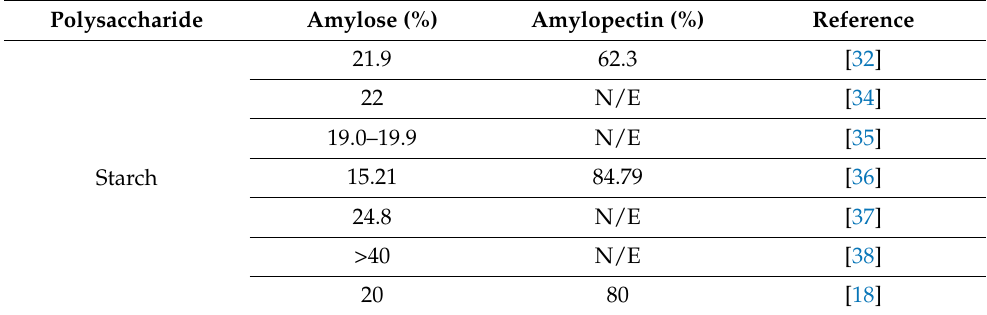
Table 2. Amylose and amylopectin composition of arrowroot rhizome starch. N/E—not evaluated. Polysaccharide Amylose